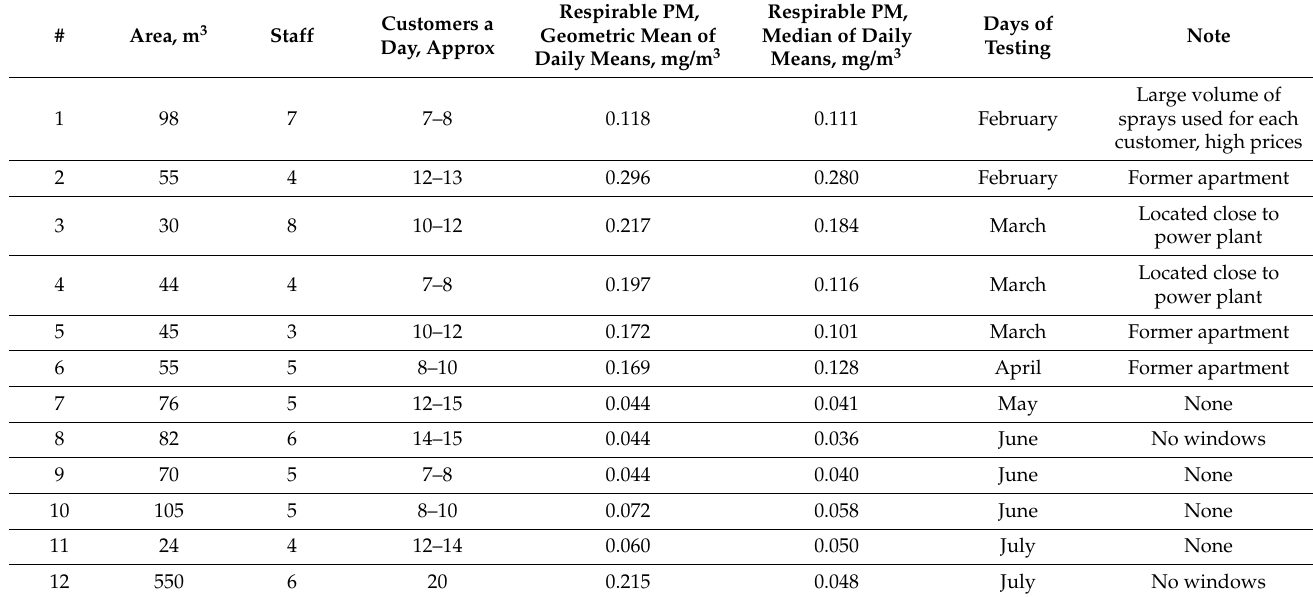
Table 1. Summary table of included